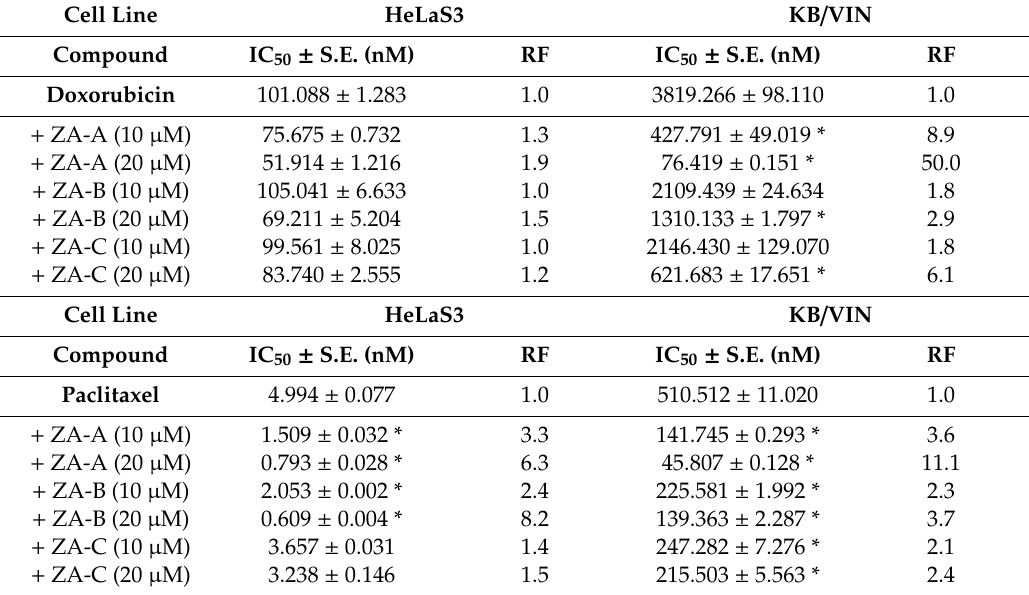
Table 2. The reversal e ff ects of ZA-A, ZA-B and ZA-C on chemotherapeutic drug resistance in MDR cancer cell line KB /